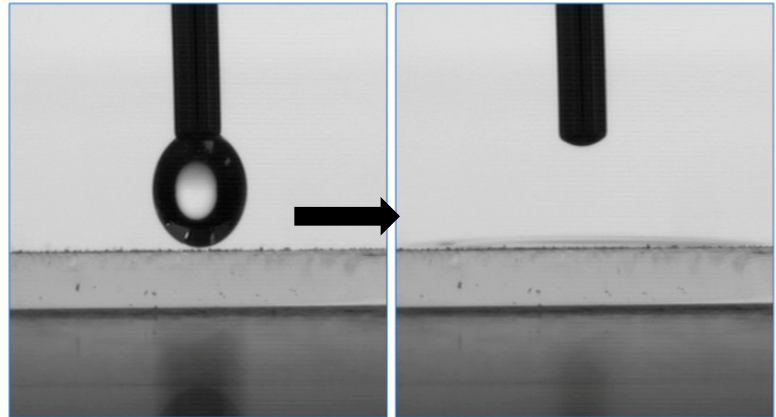
Figure 6. Water contact angle of the coated film.